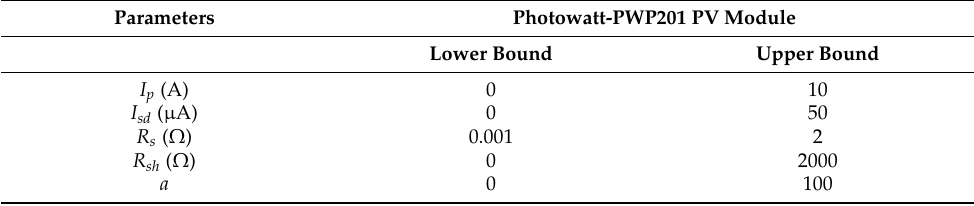
Table 1. Range of parameters for solar photovoltaic (PV)